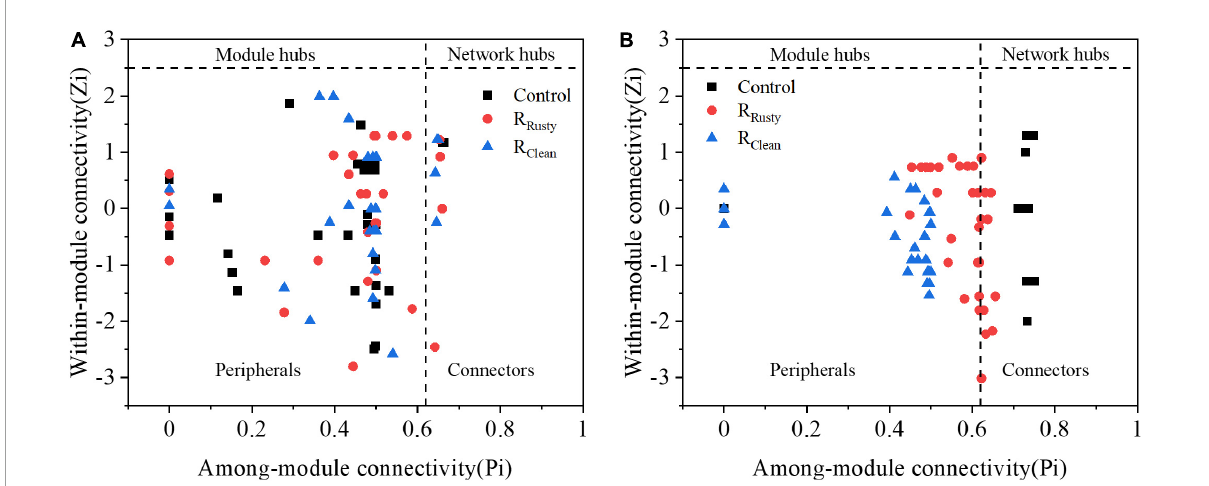
FIGURE6 Node classification to identify putative keystone species within sludge system networks. (A) Bacterial and (B) fungi. [All nodes were divided into four categories according to the among-module (Pi) and within-module (Zi) connectivity].